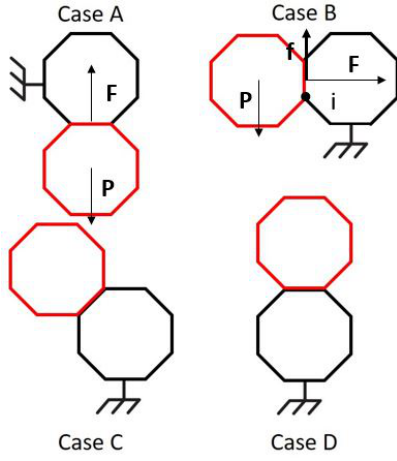
Figure 4. Different possible configurations of catoms based on face-centered cubic (FCC)